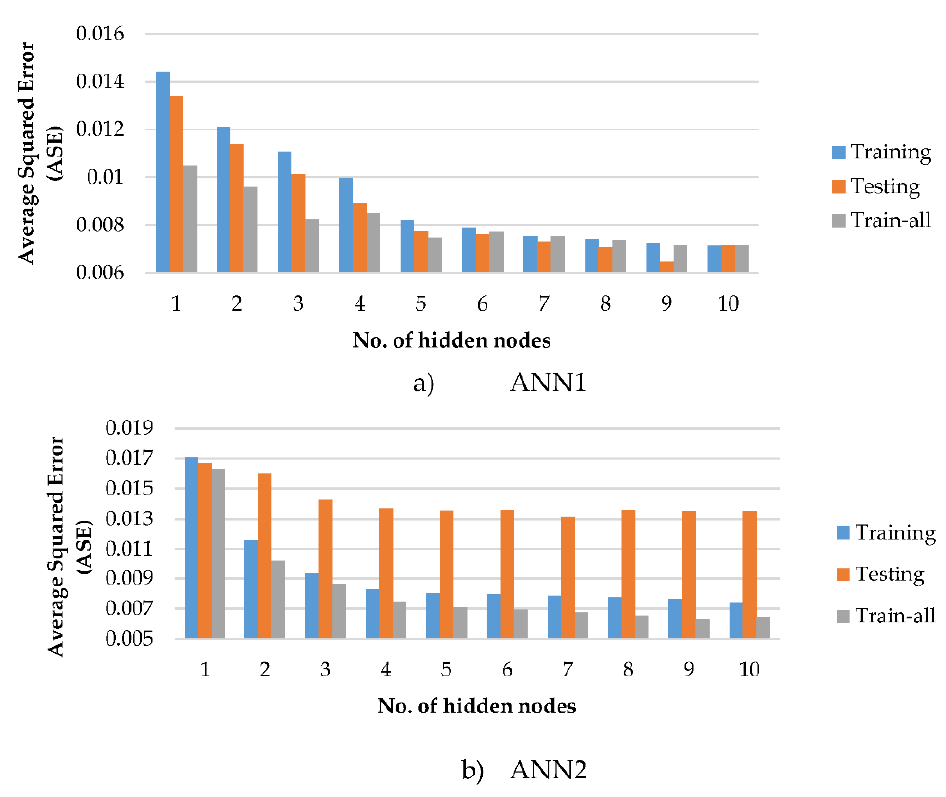
Figure 5. Average squared errors (ASE) values for networks with a different number of hidden nodes. Table 3. Connection links weight used in 5-9-4